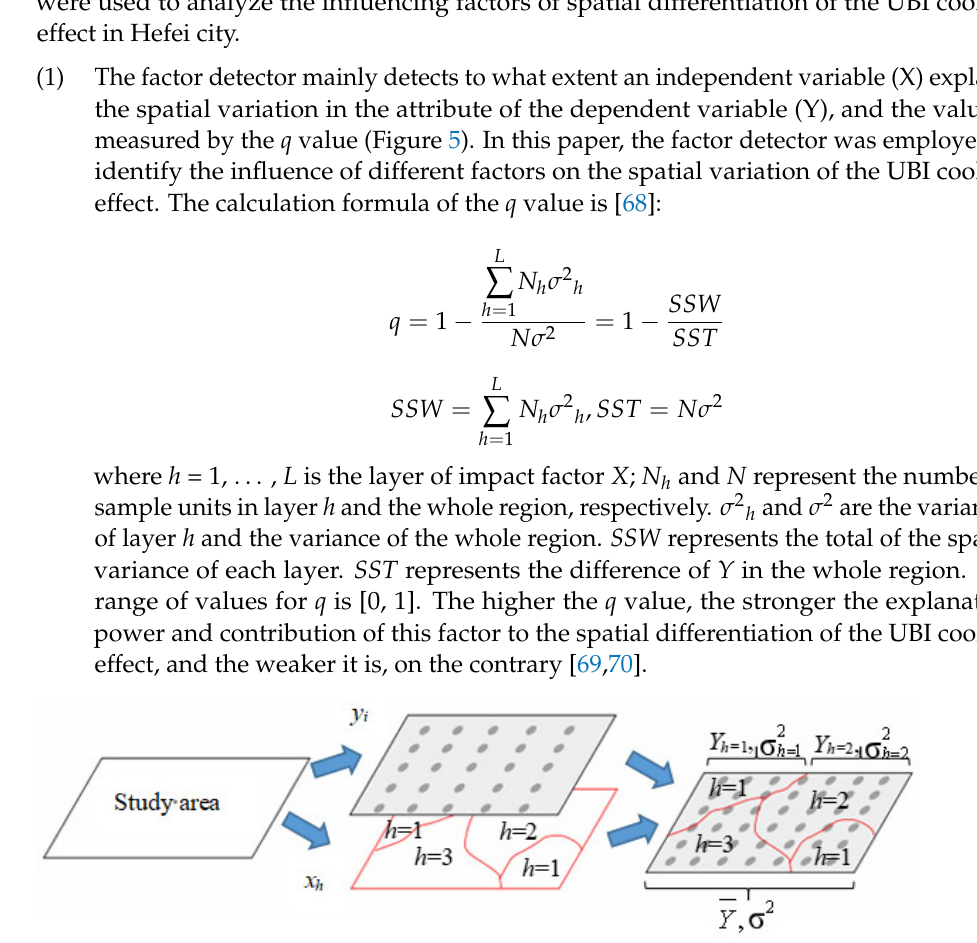
Figure 5. The principle of the factor detector.